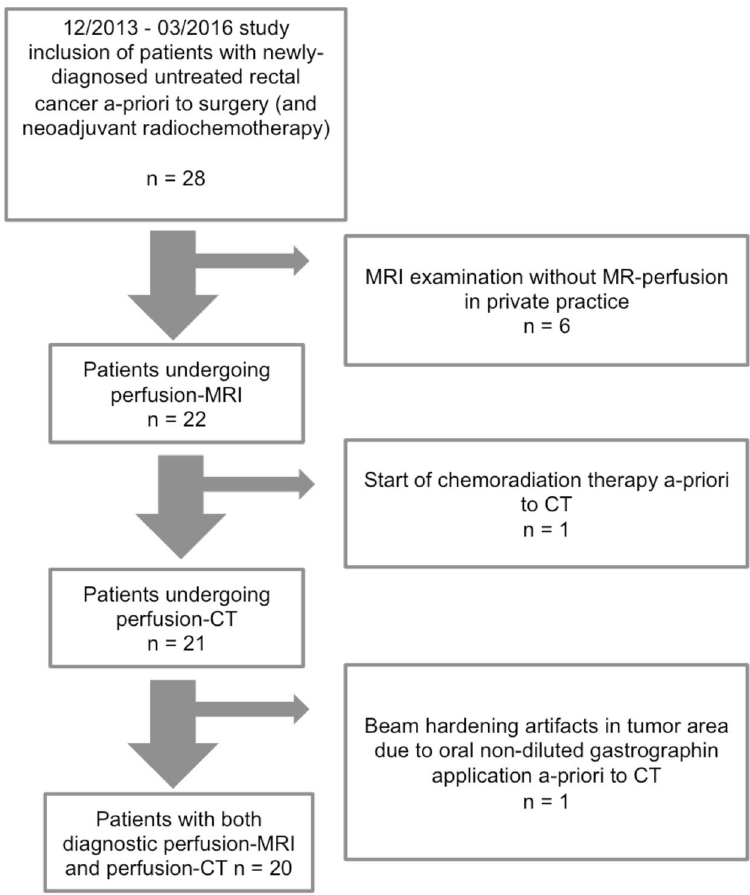
Figure 1. Study patient selection.